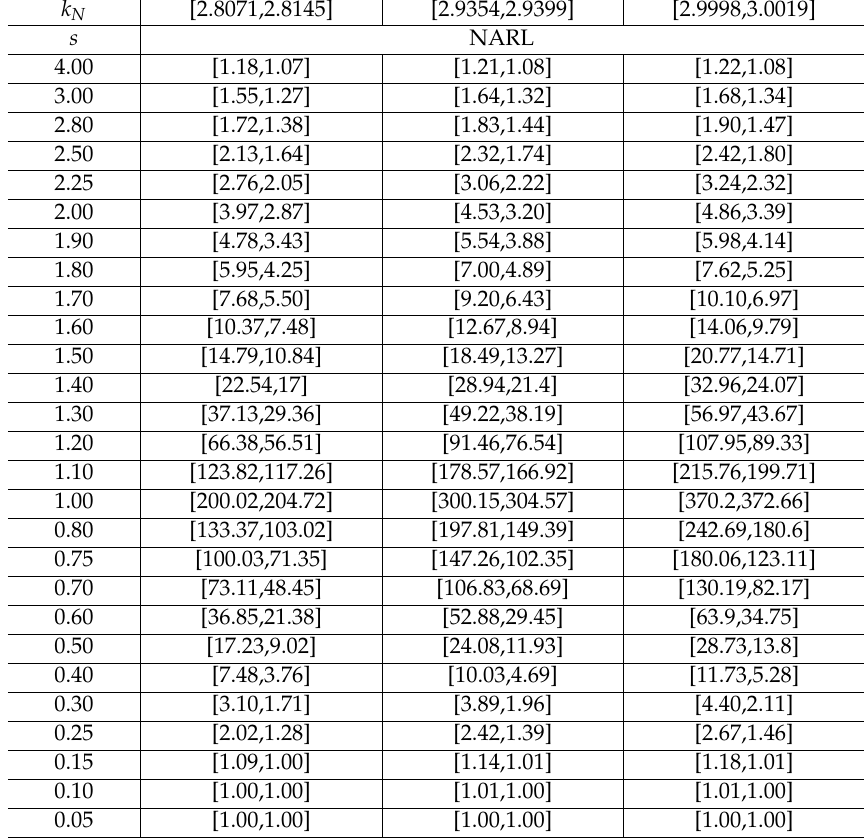
Table 4. The values of NARL when a N (cid:15) [ 0.95,1.05 ] and k N (cid:15) [ 8,10 ] . k